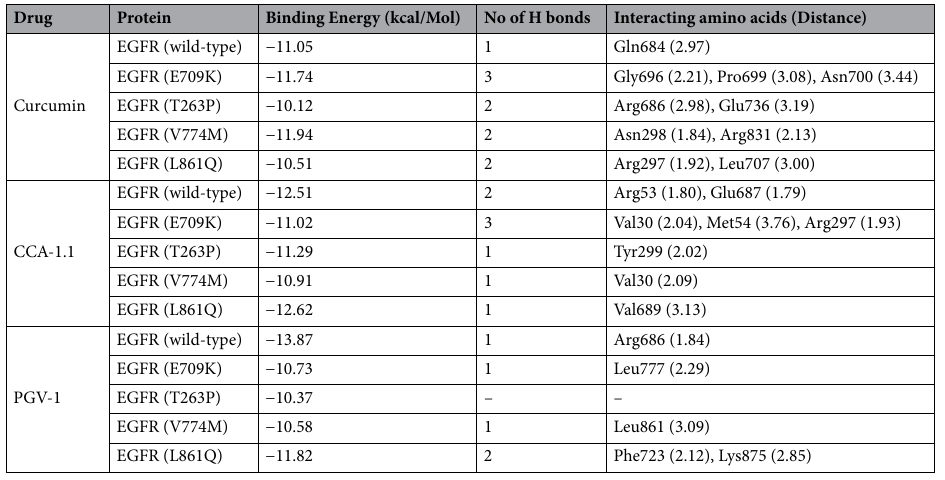
Table 6. Molecular docking scores for curcumin, CCA-1.1, and PGV-1 against wild-type and mutant